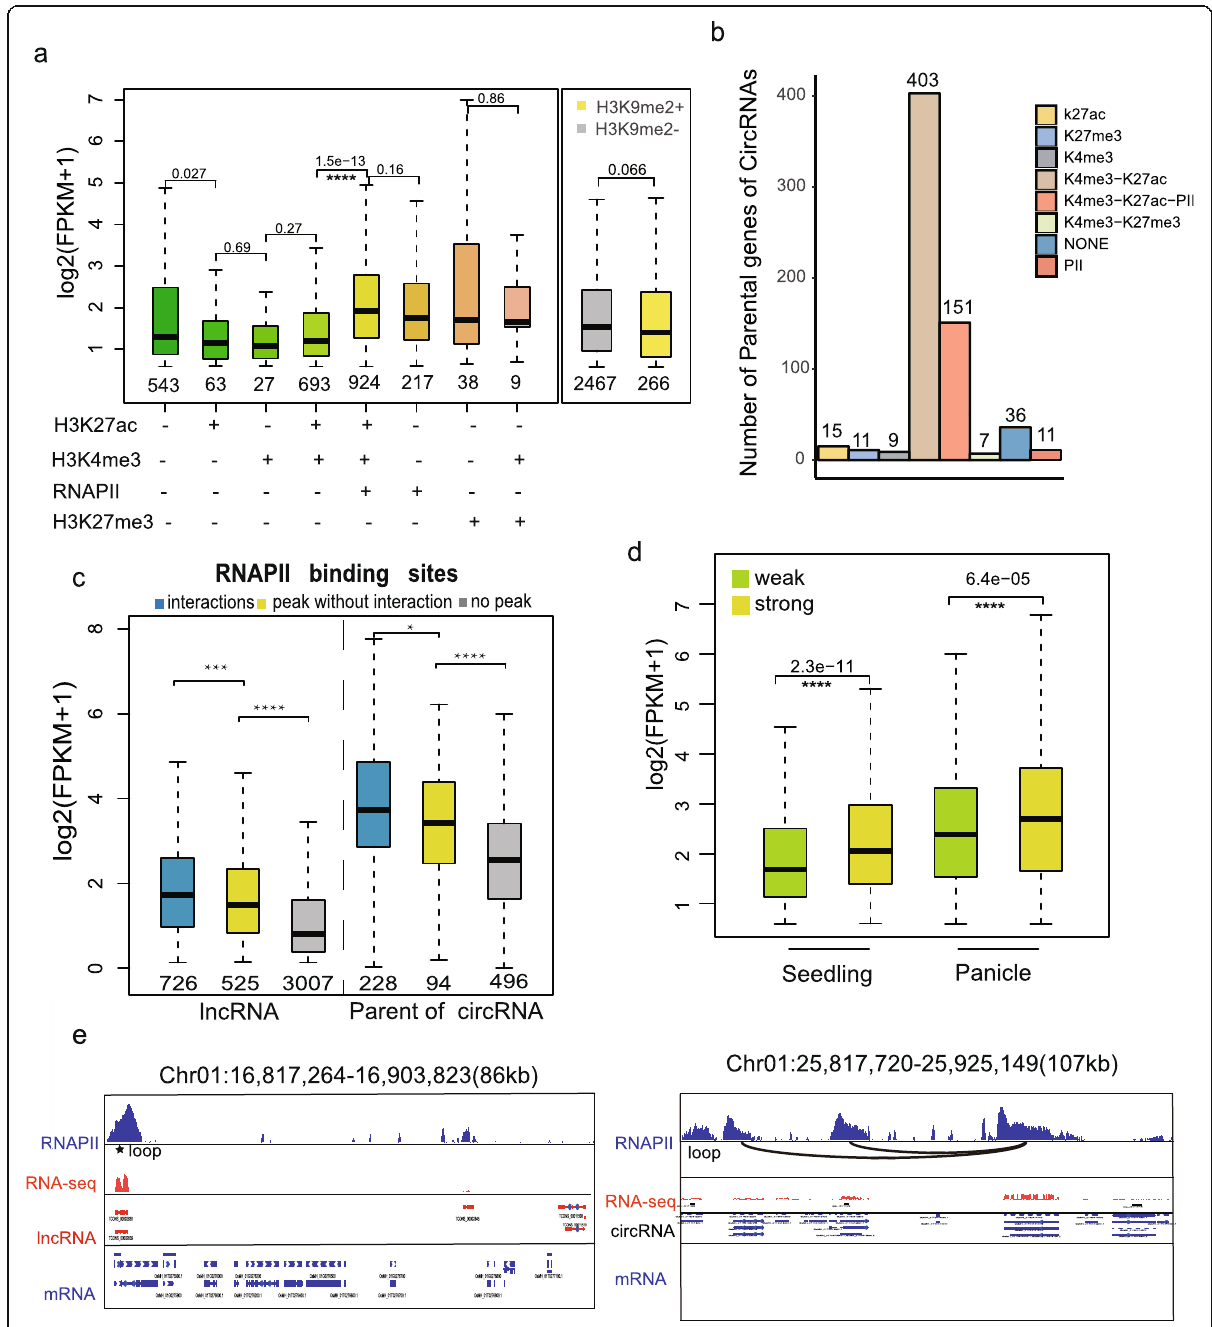
Fig. 4 Comprehensive epigenome map of lncRNA and parental genes of circRNA in MH63 seedling. a The expression changes of lncRNA loci marked by different histone modifications and RNAPII. b Numbers of P-circRNA marked by different histone markers and RNAPII. ( c ) Comparison of the number and expression (FPKM) of lncRNAs and P-circRNAs in three types, i.e., those have interactions with RNAPII binding sites and have a peak, those have a peak but no interaction and no peak. d Expression levels of lncRNA loci marked by RNAPII with weak (Green) and strong intensity (yellow). e Example of one lncRNA (up) and circRNA (down) that have RNAPII binding site (blue), their expression (red) and interactions without RNAPII signals. For example, ciri_circ147,